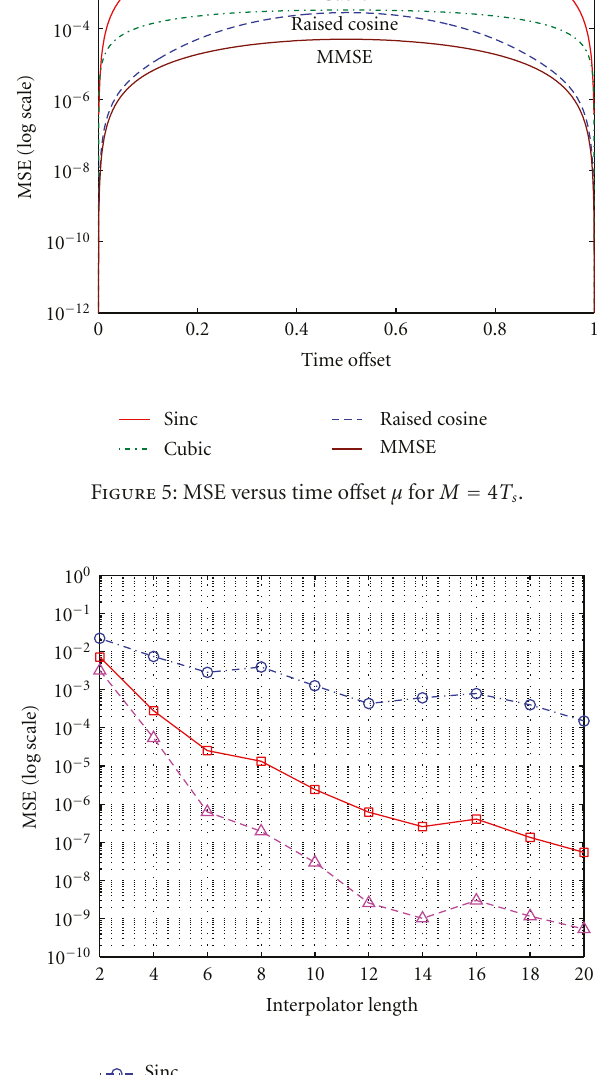
of 2 samples/symbol for truncation length M = 4 T s .